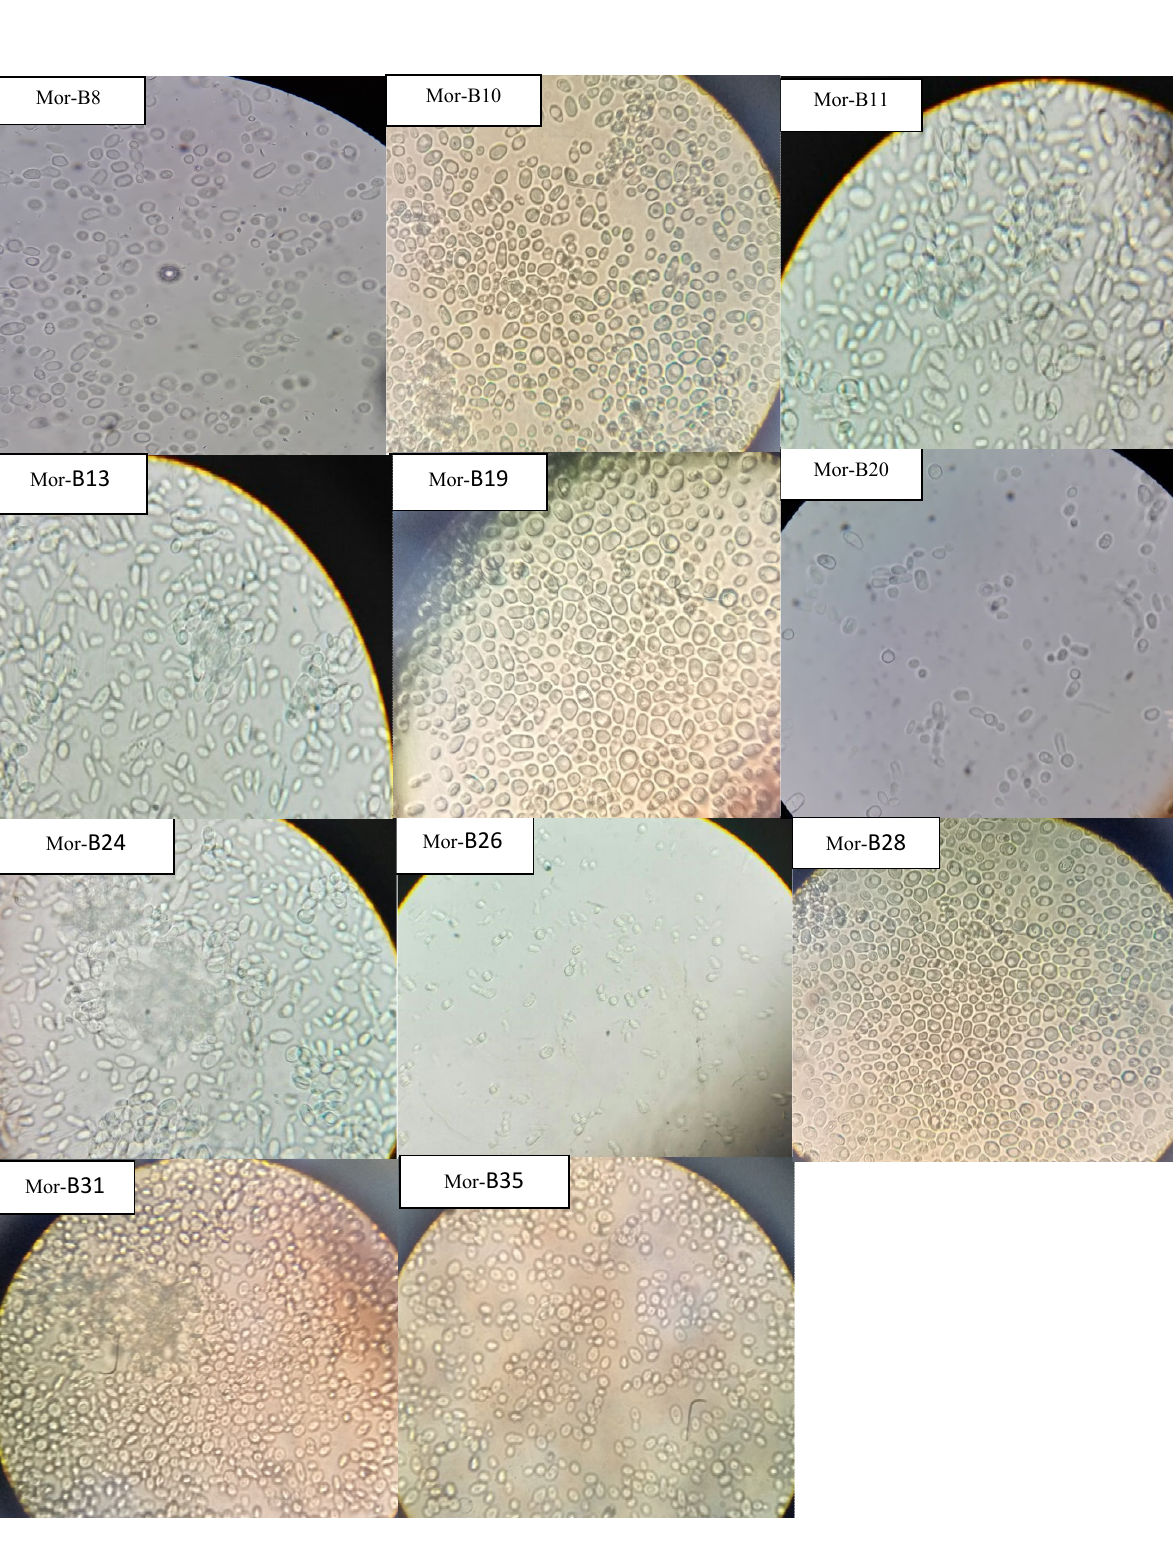
Figure 7. Morphology of different yeast isolates